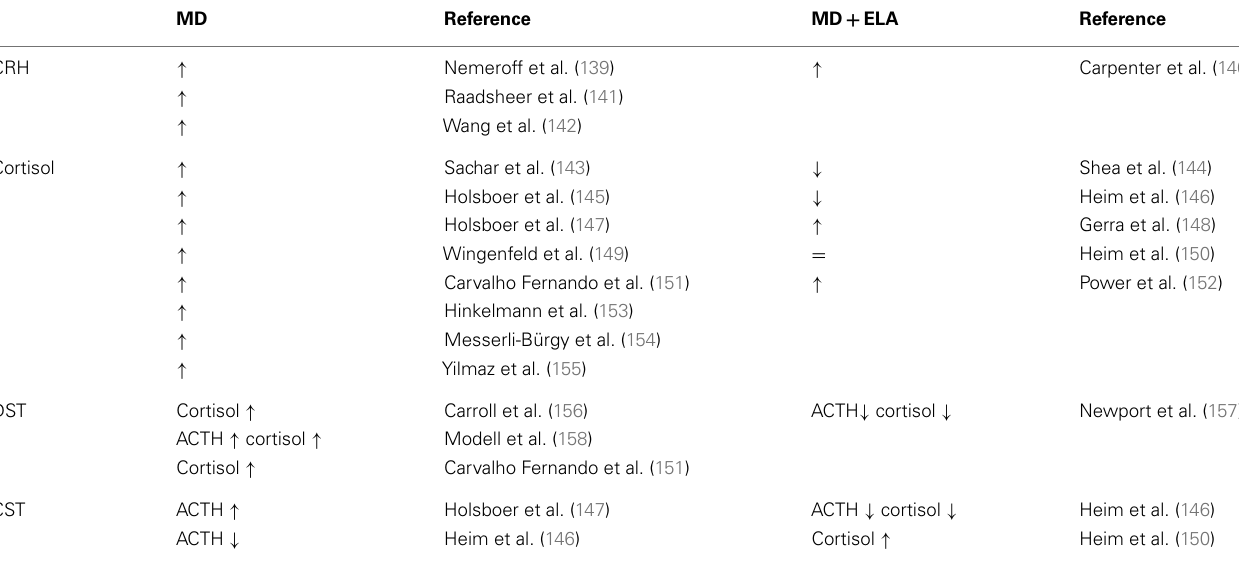
Table 1 | Neuroendocrine status in depressed patients without and with a history of early life